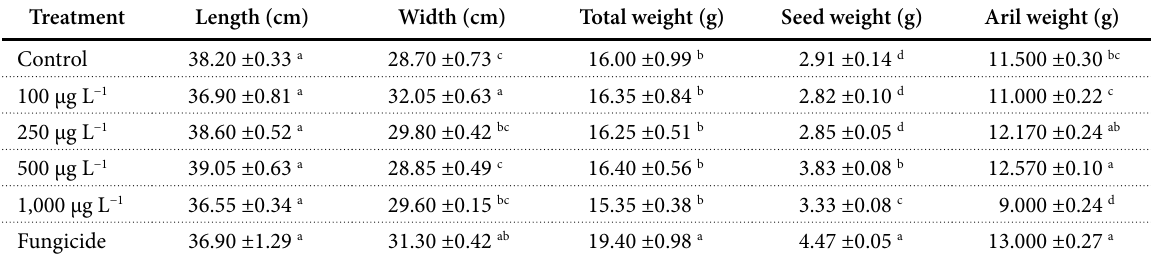
Tab. 1 Effect of chitosan on fruit length, fruit width, fruit weight, seed, and aril of litchi. Treatment